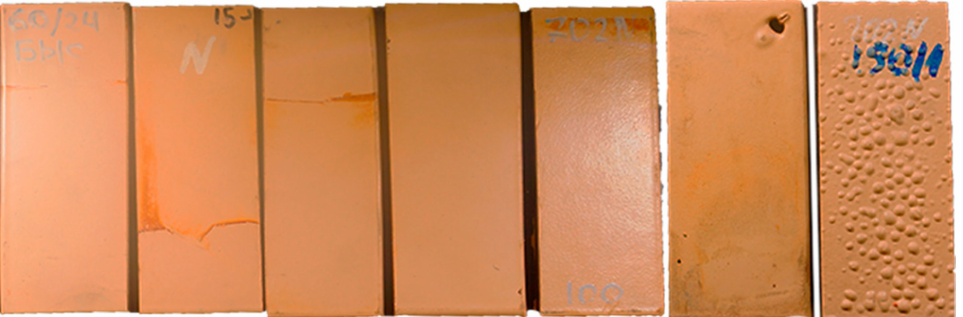
Figure 16. Change in the surface state of coated specimens after autoclave decompression tests as the test temperature